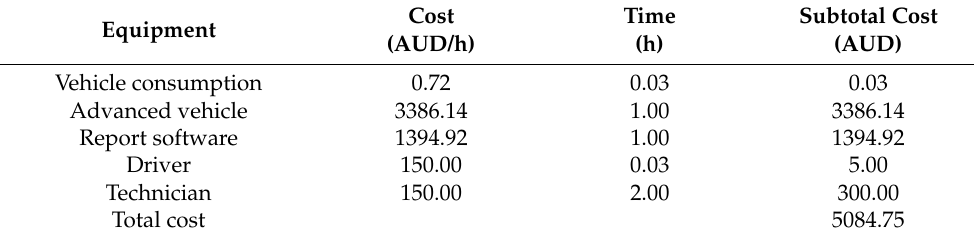
Table 5. Cost breakdown of advanced vehicle